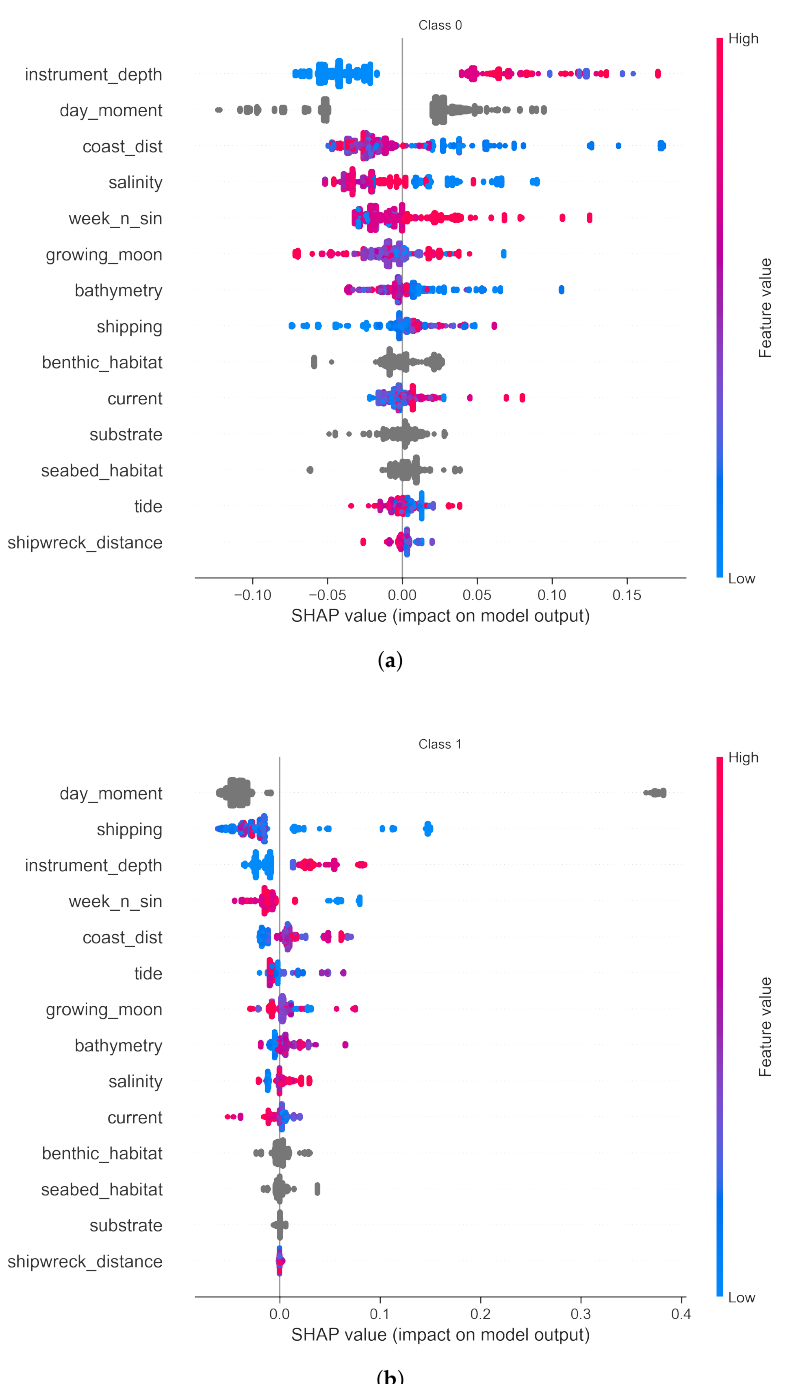
Figure 8. Summary of the SHAP values for all the environmental parameters for ( a ) class 0 ( b ) class 1. The summary of SHAP values for other classes can be seen on Figure A1. Variables in gray are categorical